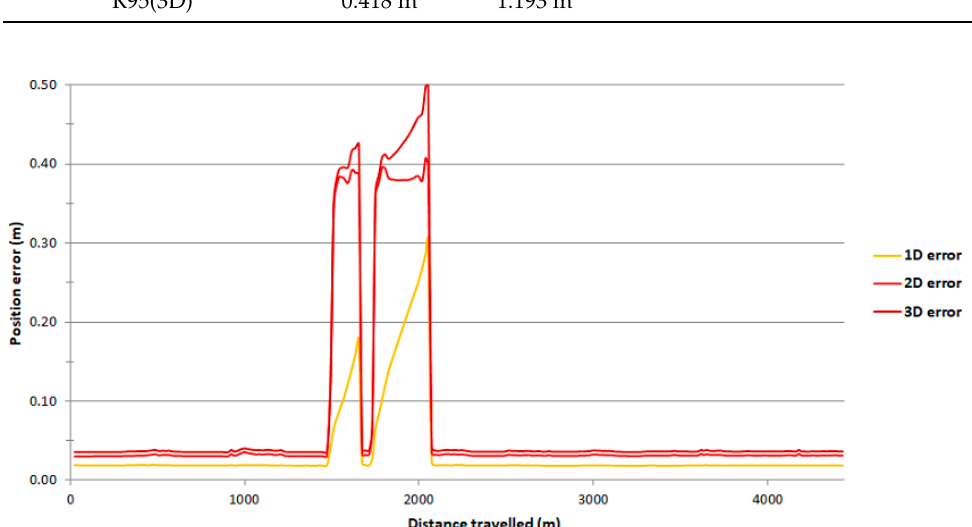
Figure 8. Variability of the 1D, 2D and 3D position errors recorded using the Ekinox2-U system in the RTK mode on route no. 1.